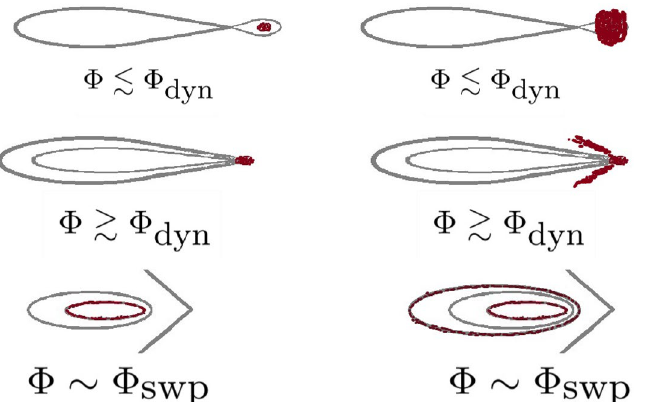
Figure 6. The spreading mechanism. The dynamics of Fig. 5 is caricatured for an optimal sweep (left panels) and for a slow sweep (right panels). The panels are ordered by time (from top to bottom). For an optimal sweep, chaos has no time to induce spreading, therefore, even if the cloud is larger (not displayed) the spreading process looks the same. For a slow sweep the outer part of the cloud has the time to spread way from the center along the chaotic strip. This chaotic spreading is initiated in the range (cid:31) dyn , as clearly observed in the upper left panel of Fig.